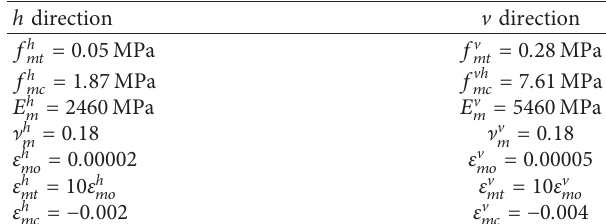
Table 2: Basic parameters of masonry for the presented numerical model.